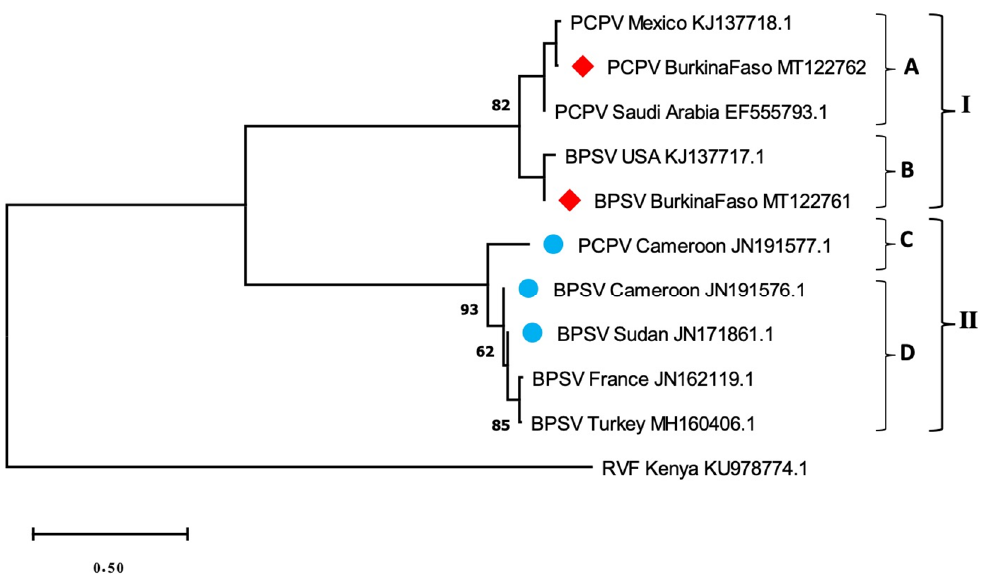
Figure 1. Localization of tick collection and positive pools of ticks in the study area (Eastern Burkina Faso) Gou: Gourma; Kom: Kompienga; Tap: Tapoa.